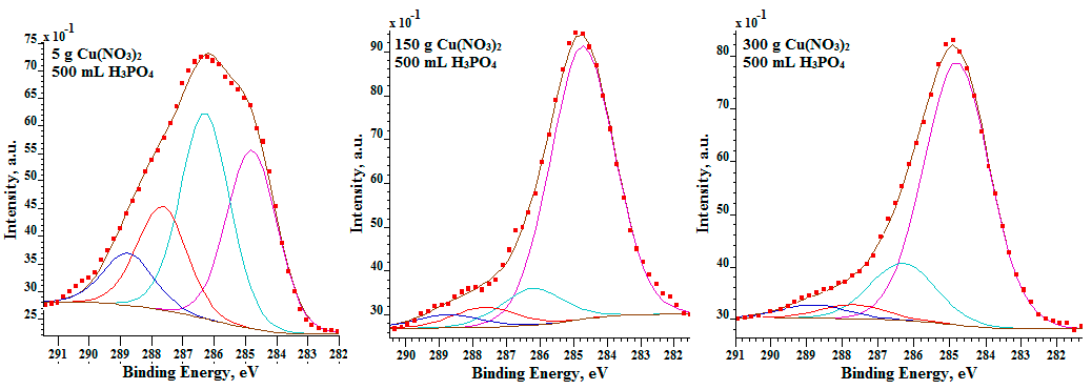
Figure 6. XPS high resolution C 1s spectra of surface layer formed on titanium after PEO.